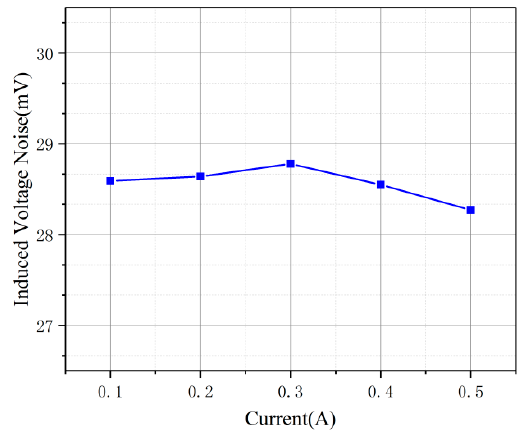
Figure 10. Variation in the induced voltage noise with the current.